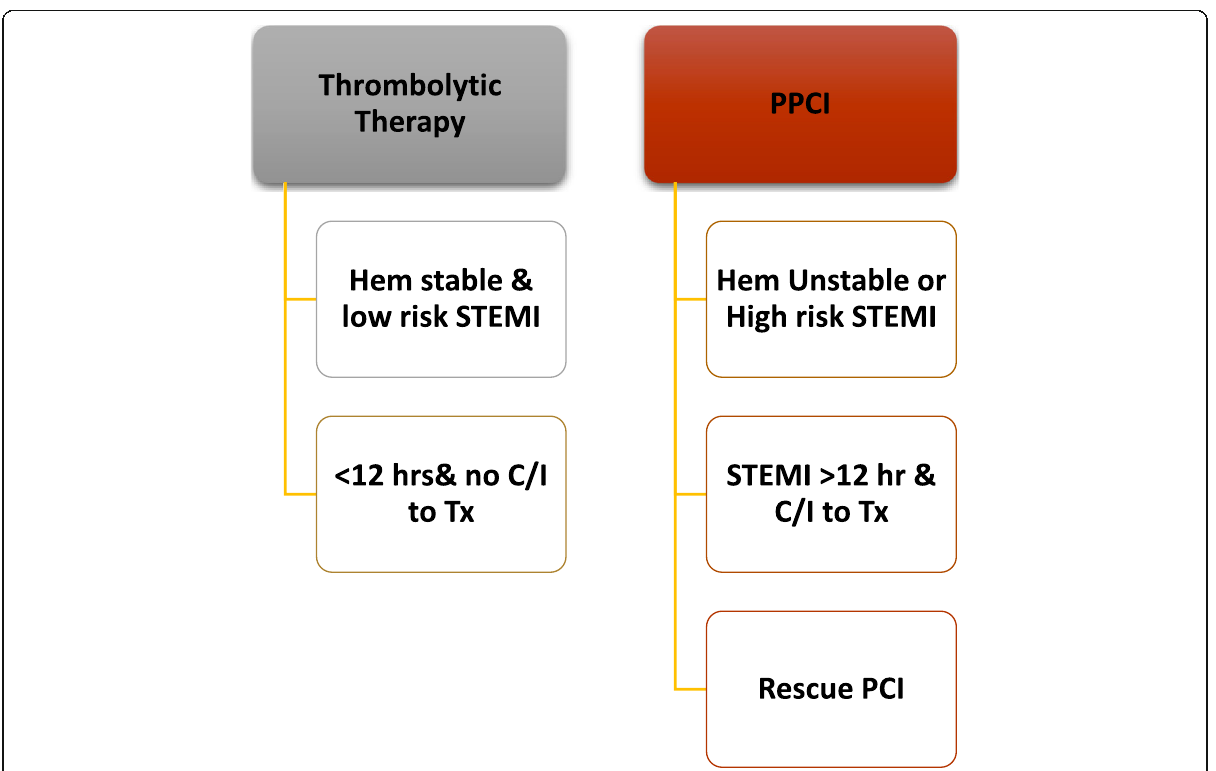
Fig. 5 STEMI management if Thrombolytic therapy is the standard strategyAfter reperfusion (whether by PPCI or lytic or conservative), patients will be transferred to isolation if COVID-19 still under investigation. Only those with twice negative PCR swabs will be transferred to cardiology CCU or ward. Patients with positive COVID-19 are immediately transferred to COVID-19 designated